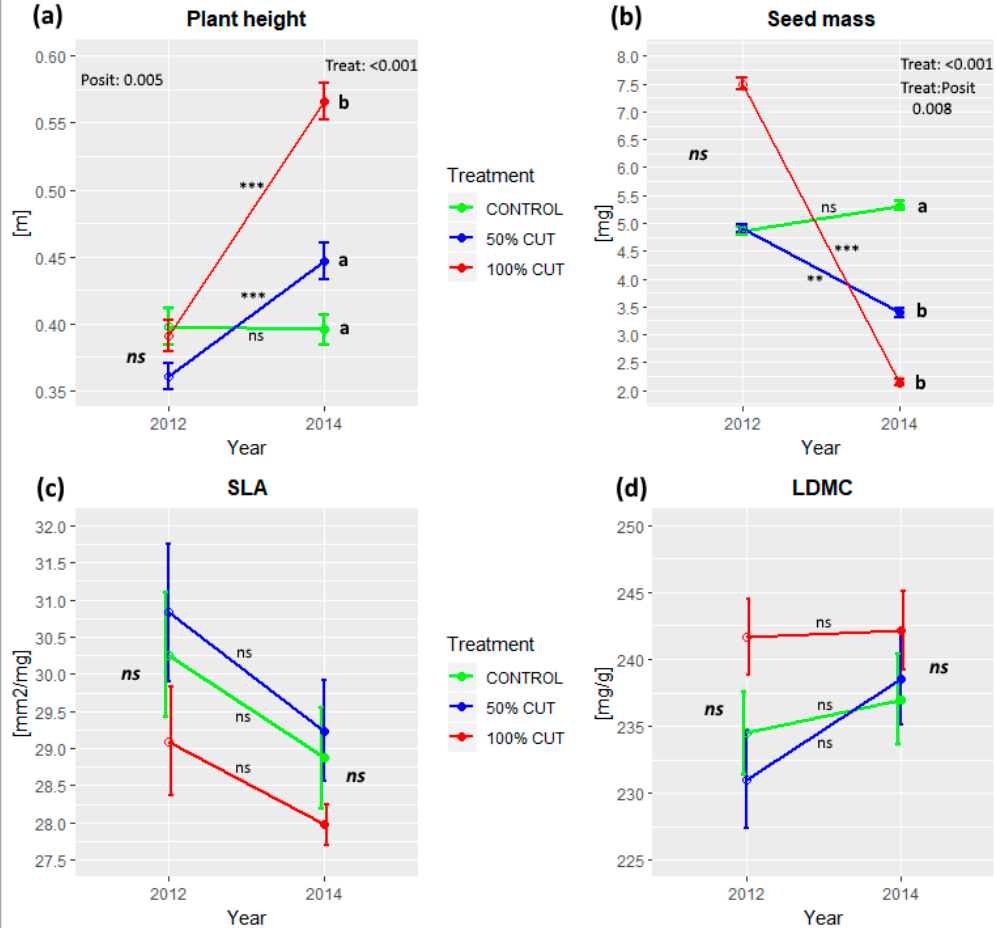
Figure 6. Community-weighted means (CWMs) for four functional traits: ( a ) plant height, ( b ) seed mass, ( c ) specific leaf area (SLA), and ( d ) leaf dry matter content (LDMC). Error bars (mean ± SE) are shown for different cutting treatments (control, 50% cut, 100% cut) in 2012 (before cutting) and in 2014 (after cutting). Inside each panel, the significant effects of fixed factors are reported ( p -values from mixed-effect models): on the left side for the year 2012 and on the right side for the year 2014. Letters in bold denote significant di ff erences between treatment intensities and “ns” stands for non-significant di ff erences between treatments. Changes from pre- to post-disturbance values are indicated by “ns” (non-significant) or asterisks (* p < 0.05, ** p < 0.01, *** p < 0.001) in the middle of each panel, close to the lines connecting error